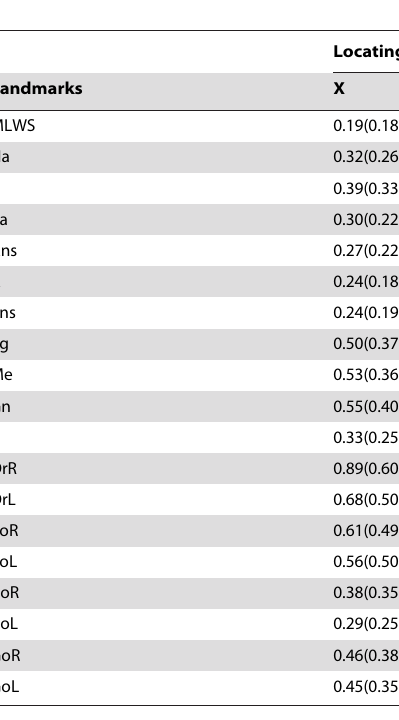
Table 2. Locating error (coordinate).